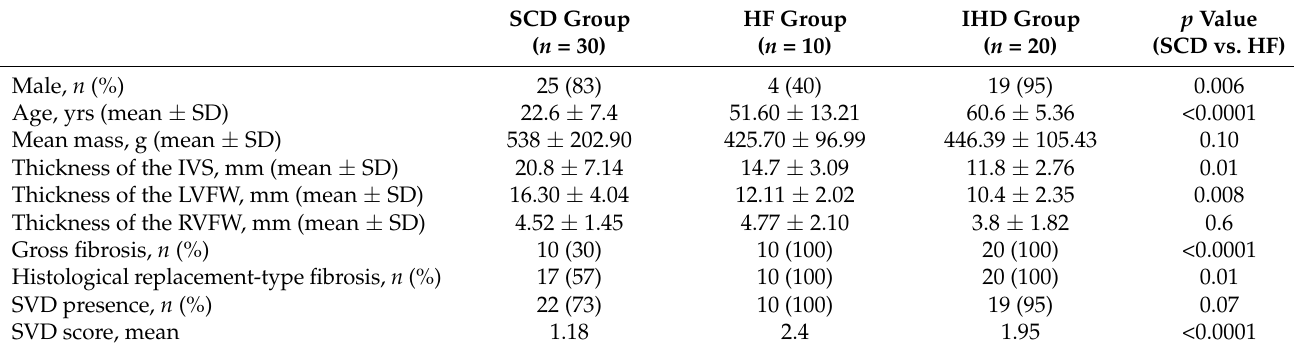
Table 1. Study groups: main cardiac pathological findings.